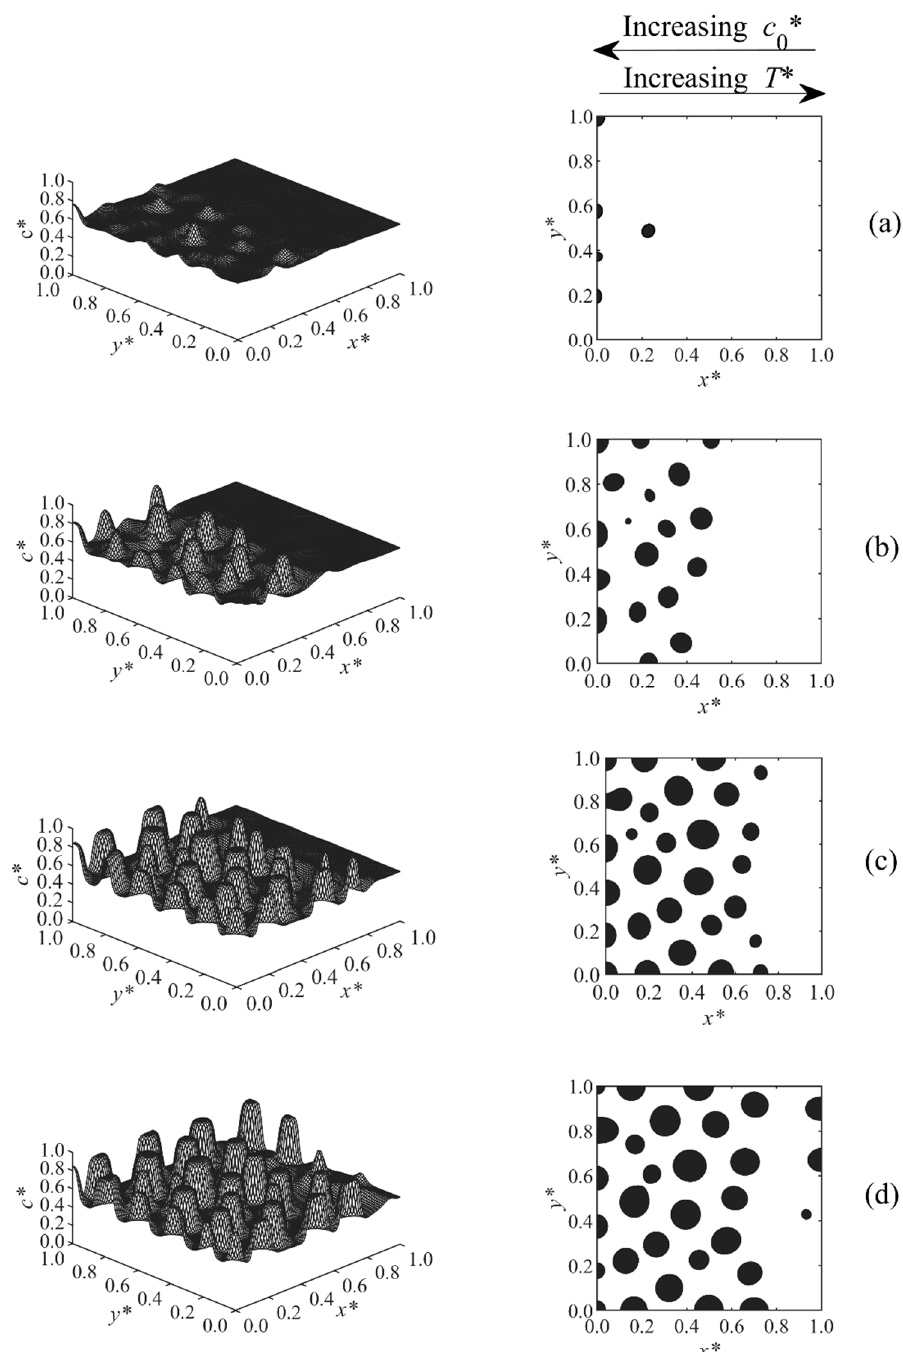
Figure 8. Spatial concentration profiles (first column) and phase-separated patterns (second column) for Case 7 at the following times: ( a ) t ∗ = 5.66 × 10 − 5 , ( b ) t ∗ = 5.7 × 10 − 5 , ( c ) t ∗ = 5.8 × 10 − 5 , and ( d ) t ∗ = 5.9 × 10 − 5 .